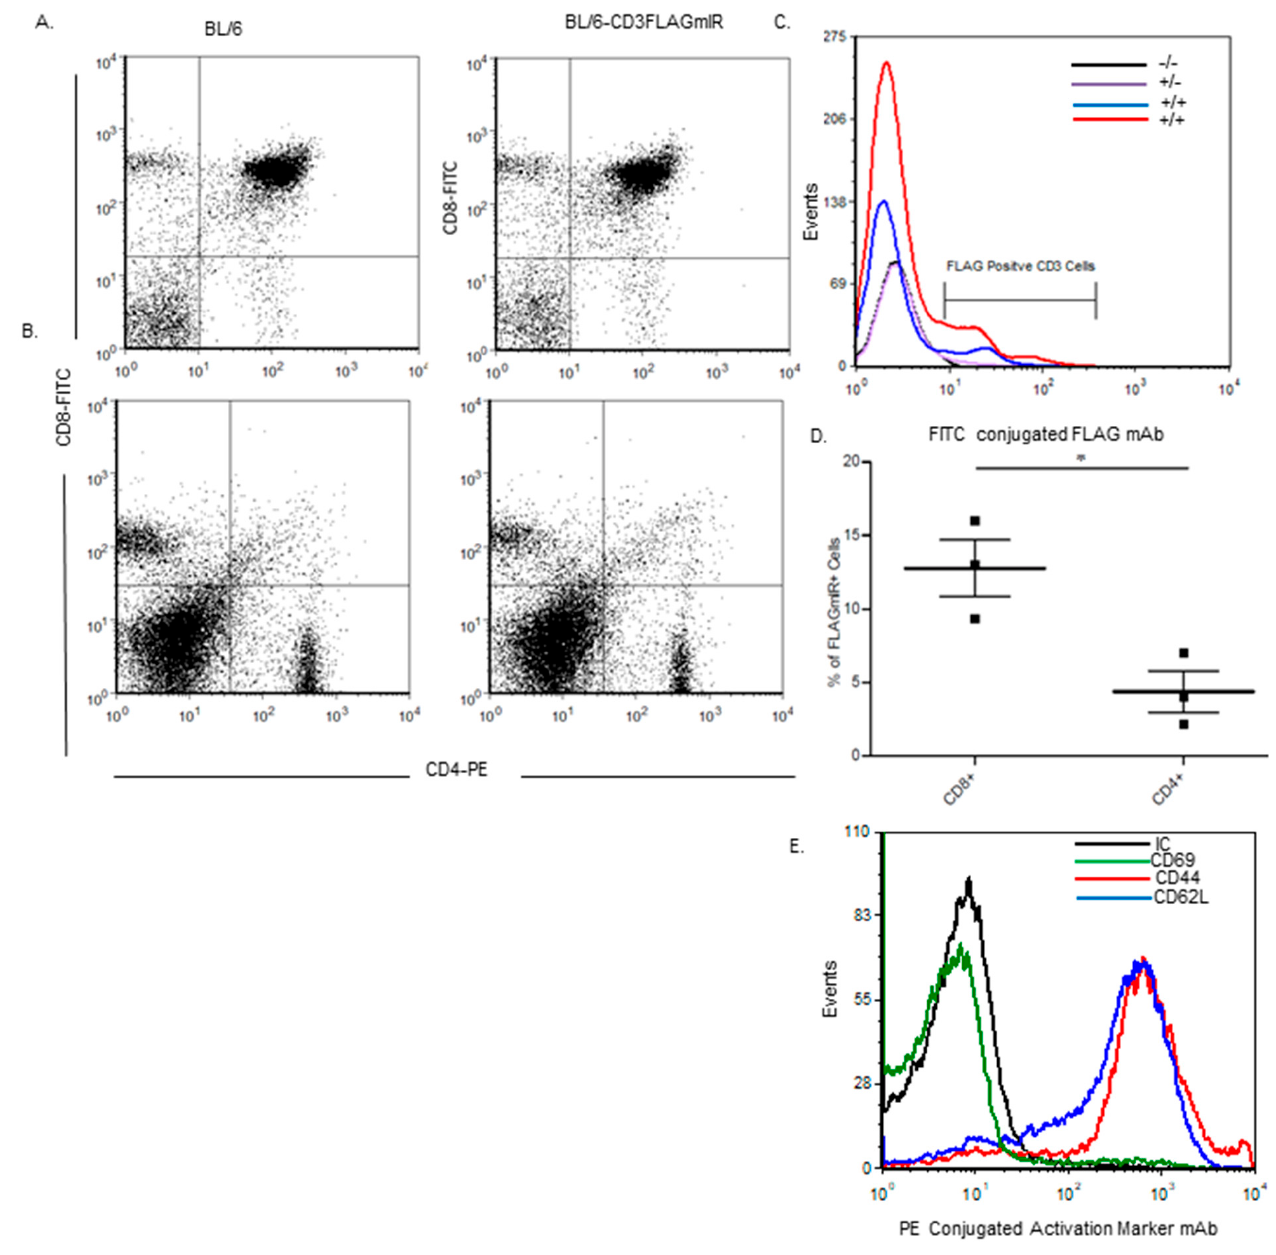
Figure 2. Study of CD4, CD8, FLAG expression, and activation markers on splenocytes or thymocytes of 25-week-old BL/6 and Bl/6-CD3FLAGmIR mice. ( A ) Expression comparison of thymic cell subpopulations of BL/6 and Bl/6-CD3FLAGmIR mice by flow cytometry, stained with anti-CD4 FITC, anti-CD8 PE, and anti-CD3-APC antibodies. The dot plots shown are gated on the CD3-APC-positive cell population from whole thymus ( B ) Expression comparison of splenic cell subpopulations of BL/6 and BL/6-CD3FLAGmIR mice by flow cytometry, stained with anti-CD4 FITC, anti-CD8 PE, and anti-CD3-APC antibodies. The dot plots shown are gated on the CD3-APC-positive cell population from whole spleen. ( C ) Splenocytes stained for expression of FLAGmIR transgene and gated on the CD3-APC-positive population. The black line (control) overlaps the violet line except at the end. ( D ) Percentage of FLAG + CD8 + versus FLAG + CD4 + splenocytes from BL/6-CD3FLAGmIR mice at 25 weeks of age. ( E ) Adhesion and Activation Marker analysis of transgene FLAGmIR + splenocytes stained with either anti-CD44 PE, anti-CD62L PE, or anti-CD69PE and gated on the CD3 + , FLAGmIR + -positive cell population. FLAGmIR + T cells from Bl/6-CD3FLAGmIR mice are CD44 + and CD62L + . These data are representative of 3 separate experiments. Unpaired student t test: * p ≤ 0.05.